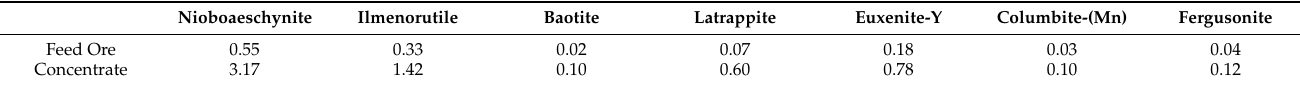
Table 8. Comparison of niobium mineral composition in concentrate and feed ore